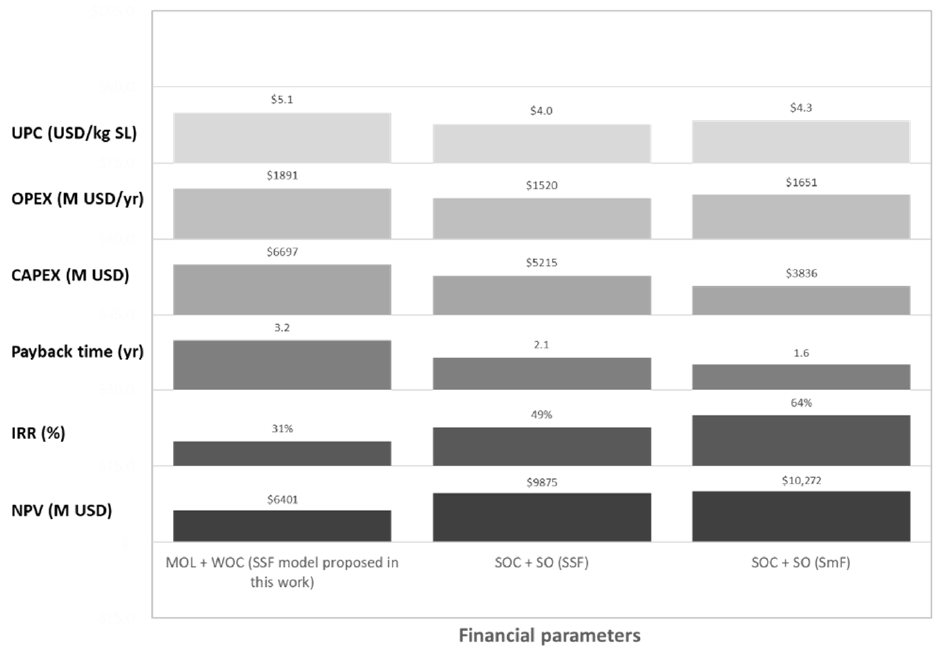
Figure 5. Financial parameters for the SLs production scenarios using sunflower oil cake (SOC) and soybean oil (SO) as substrates. SSF: Solid State Fermentation. SmF: Submerged fermentation.